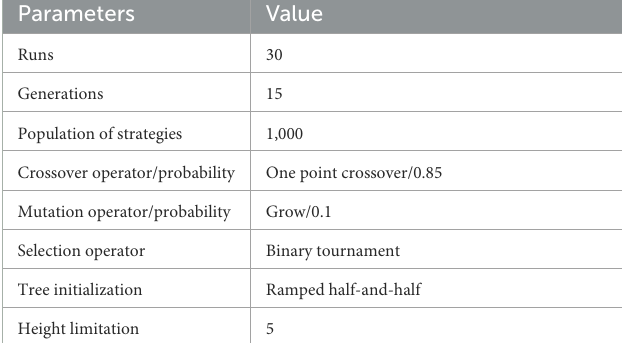
TABLE 3 Evolutionary learning